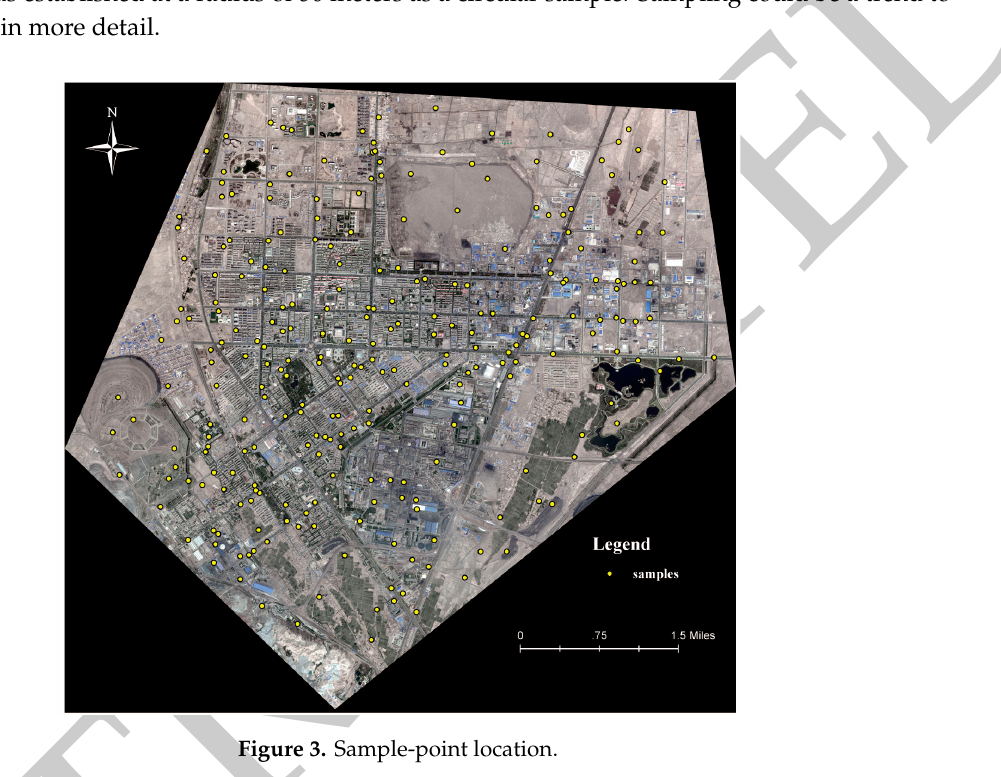
Figure 3. Sample-point location.